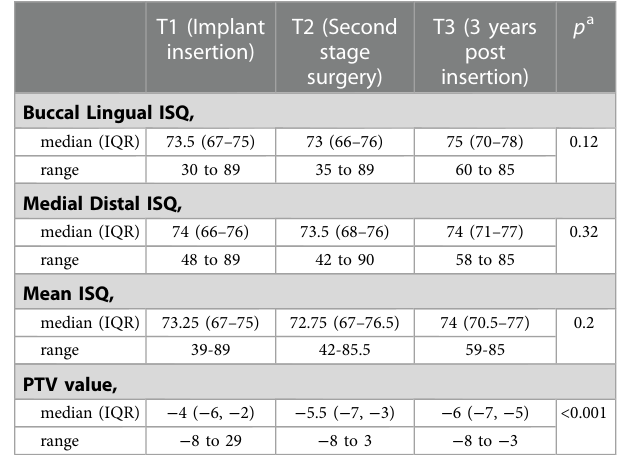
TABLE 1 Implant stability measurements by time